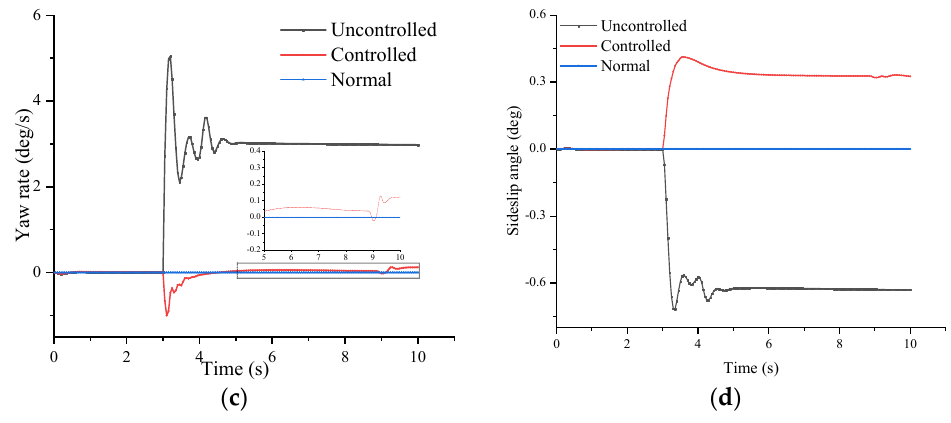
Figure 7. The controlled simulation curve of left rear tire blowout: ( a ) lateral acceleration curve; ( b ) lateral displacement curve; ( c ) yaw rate curve; ( d ) sideslip angle curve.